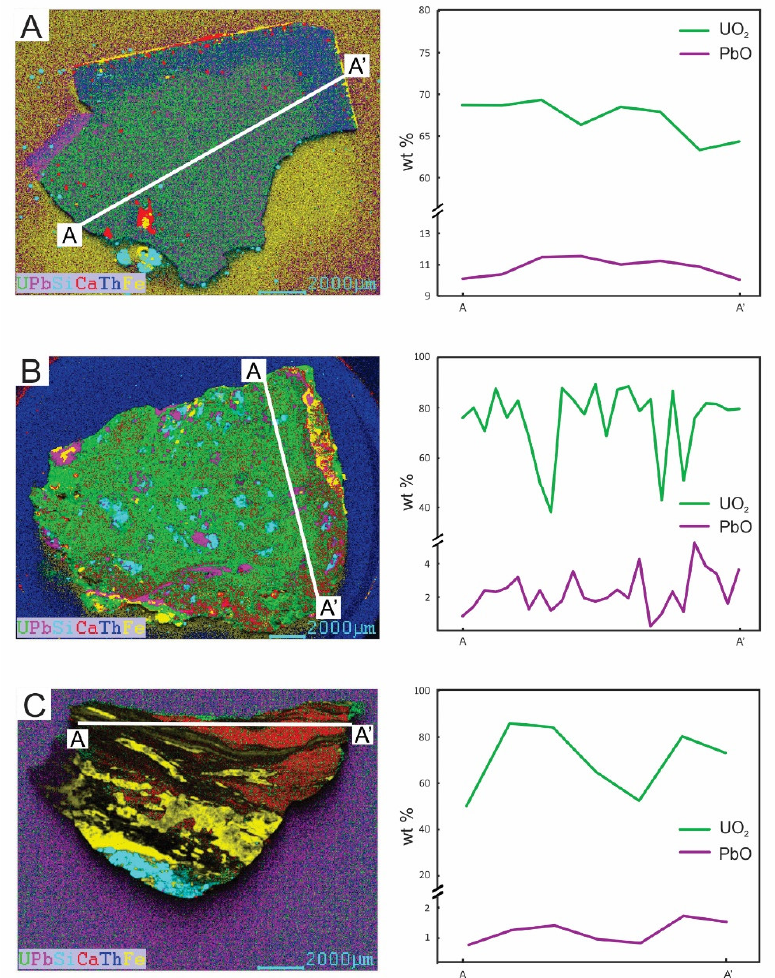
Figure 2. XRF elemental maps for three uraninite samples investigated here: ( A ) Bancroft, ( B ) Marshall Pass, and ( C ) Adair Mine are shown on the left. Each of the XRF maps has a transect indicated A to A’, which corresponds to the UO 2 and PbO abundances profile given in the line graphs. The transects illustrate the degree of alteration within each sample.